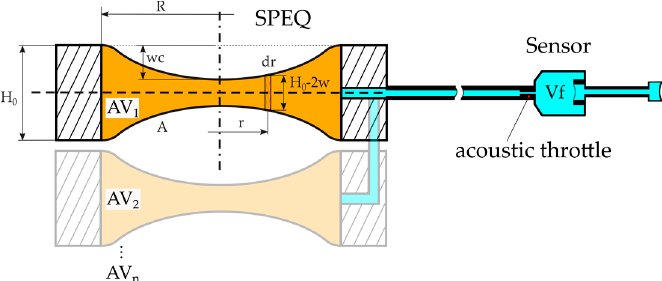
Figure 5. Schematic drawing of the static pressure equalization (SPEQ) system of an intracochlear acoustic receiver (ICAR) that is based on an adaptive volume (AV) consisting of a stack of n diaphragm pairs suspended on a rigid support structure.